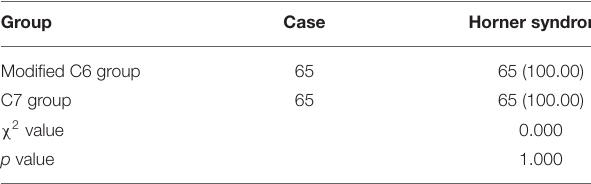
TABLE 4 | Comparison of blockade between the two groups [ n